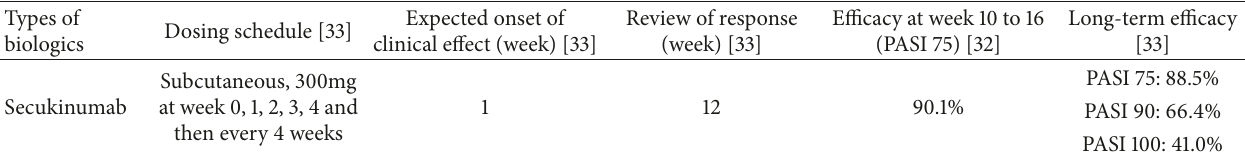
Table 1: Dosing schedule and efficacy of secukinumab.